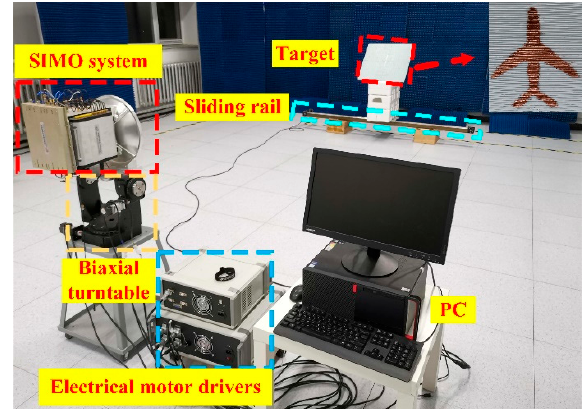
Figure 7. The experiment set-up in laboratory environment.